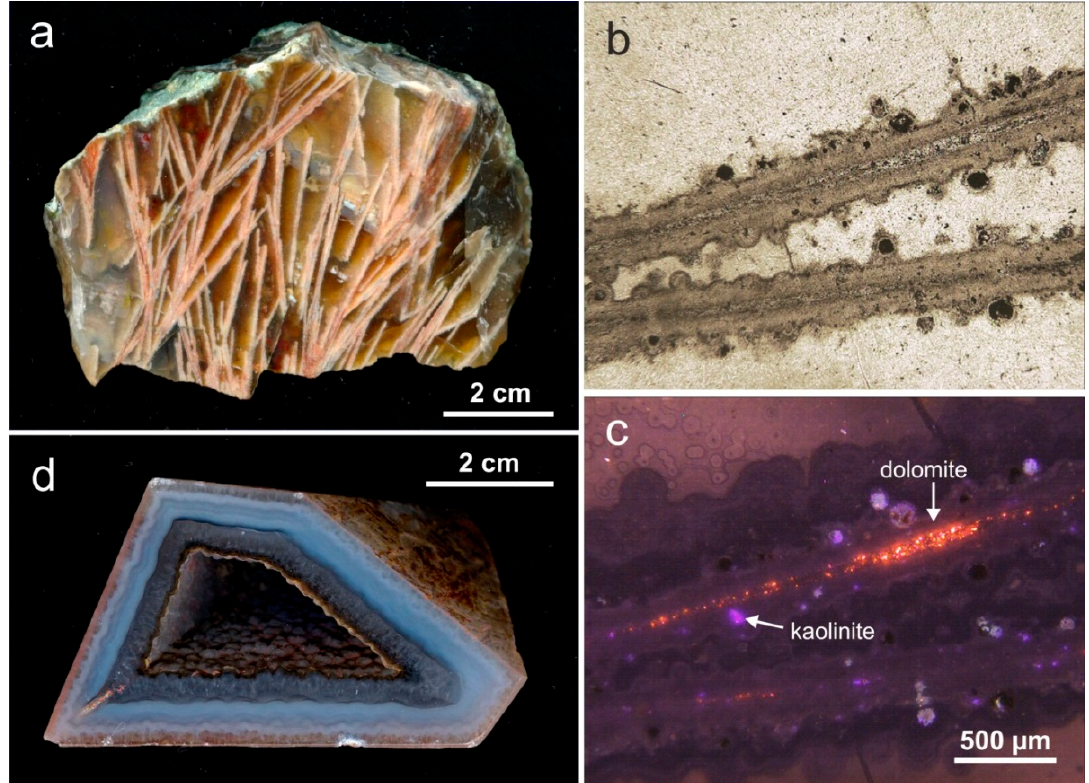
Figure 23. ( a ) Pseudomorphic mineral formation in an agate from Liebgensmühle (Saxony, Germany); ( b ) micrograph in transmitted light showing details of the lath ‐ shaped crystals; ( c ) CL micrograph of the same area, which reveals relics of dolomite in the core of the lath ‐ shaped crystals as well as tiny kaolinite from alteration processes; ( d ) agate from Cachoeira dos Índios, Paraiba (Brazil); the polygonal shape developed due to infill of silica into interstices between laminated calcite (or barite) crystals.